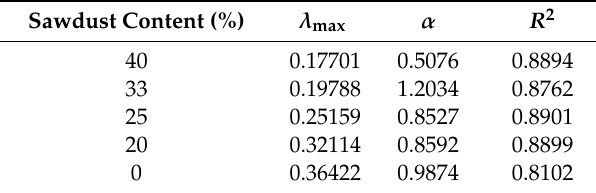
Table 6. Fitted maximum damping ratio and parameter α for various sawdust contents.